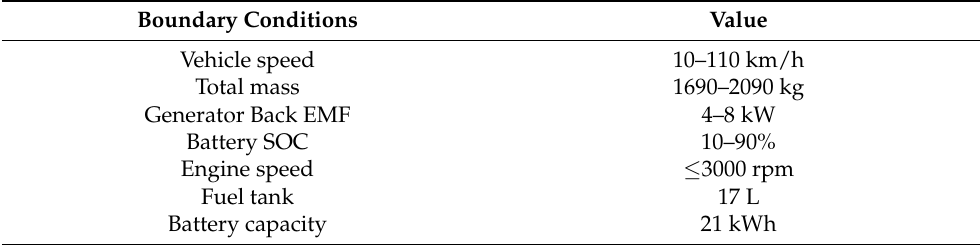
Table 1. Boundary conditions of Matlab/Simulink